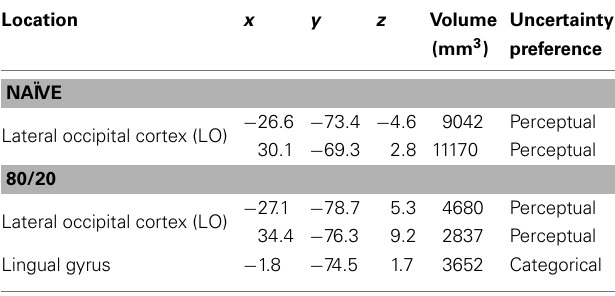
Table 3 | Brain regions selective for uncertainty condition when activity was defined as covariation with degree of uncertainty.